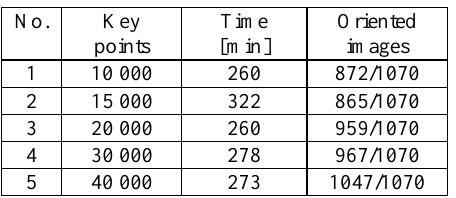
Table 4. Time and effectiveness of orientation in AgiSoft